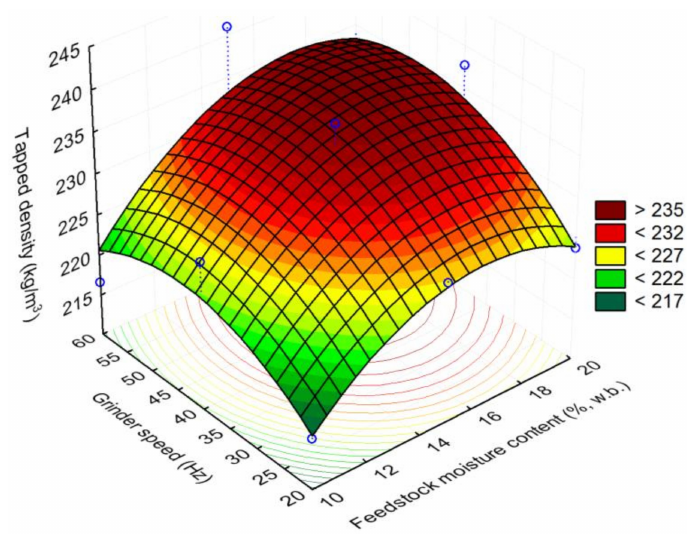
Figure 11. The effect of feedstock moisture content and grinder speed on tapped density.